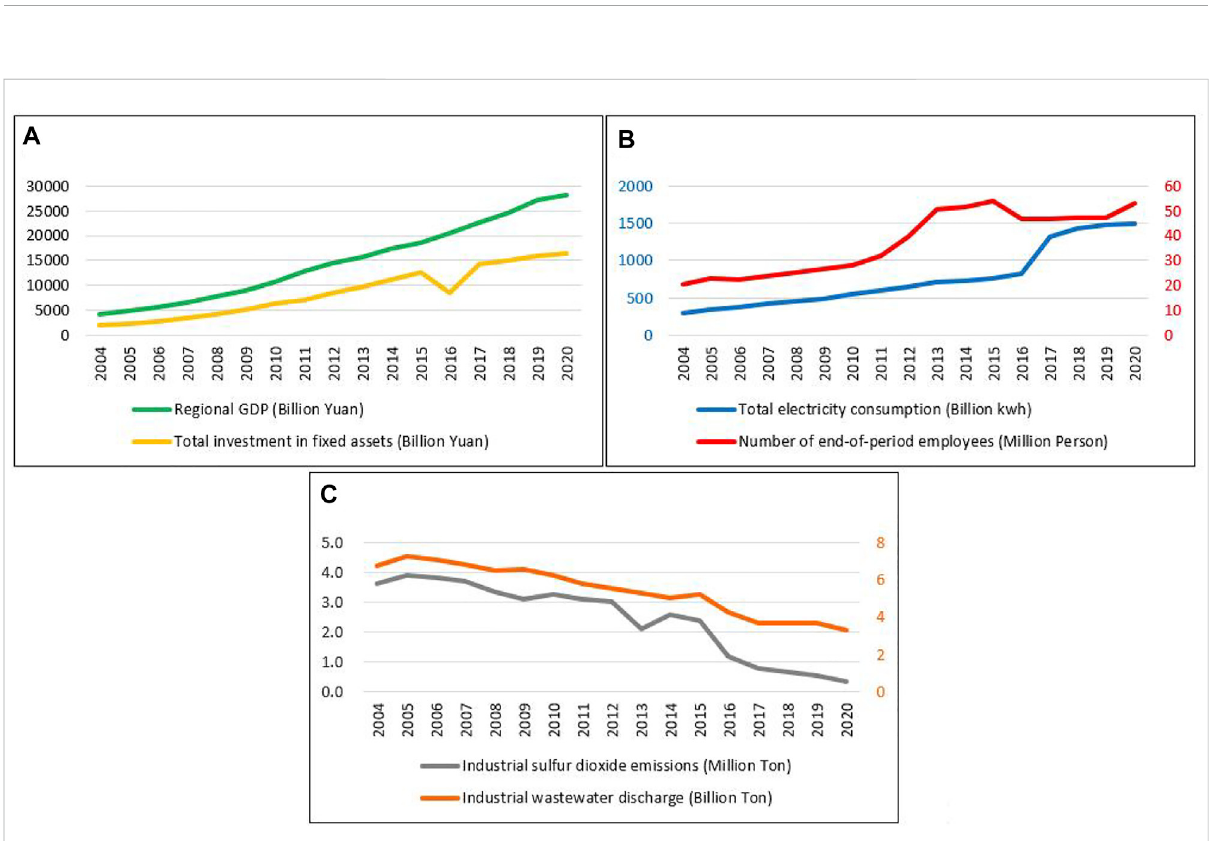
FIGURE 1 Descriptive statistics of each indicator. (A) Regional GDP and Total investment in fi xed assets; (B) Total electricity consumption and Number of employees; (C) Industrial wastewater discharge and Industrial SO 2